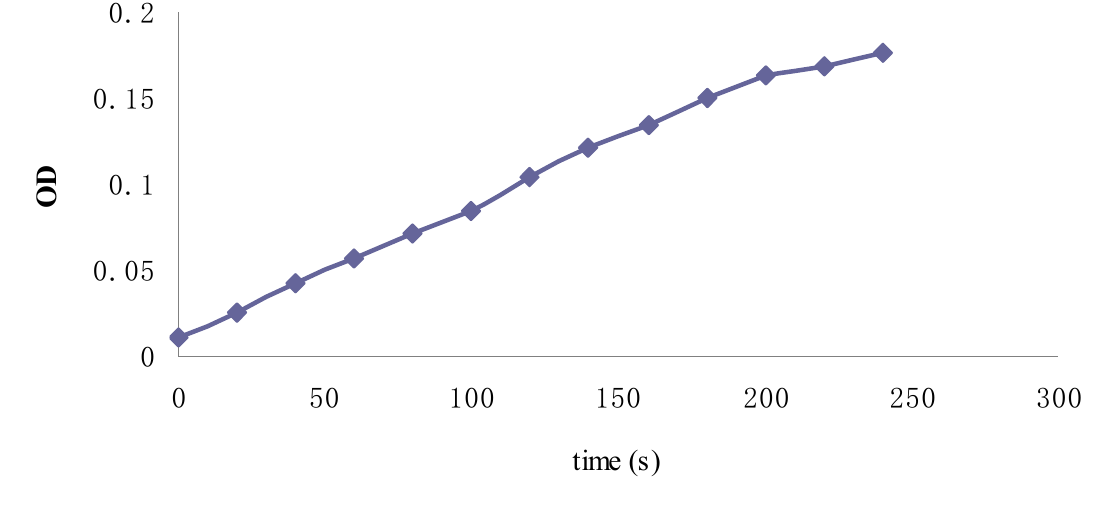
Figure 13. Relationship between the OD and time for determination of THDB